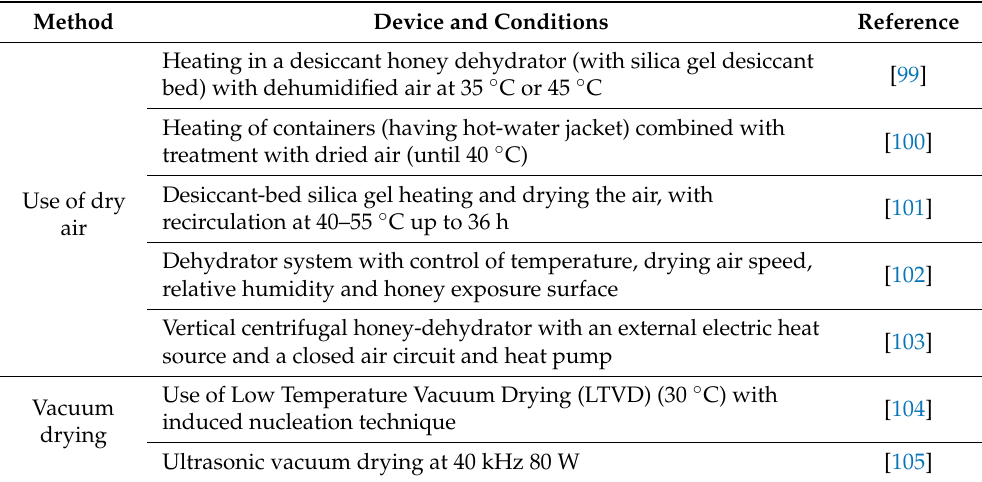
Table 1. Honey dewatering and dehumidification methods used in the last 12